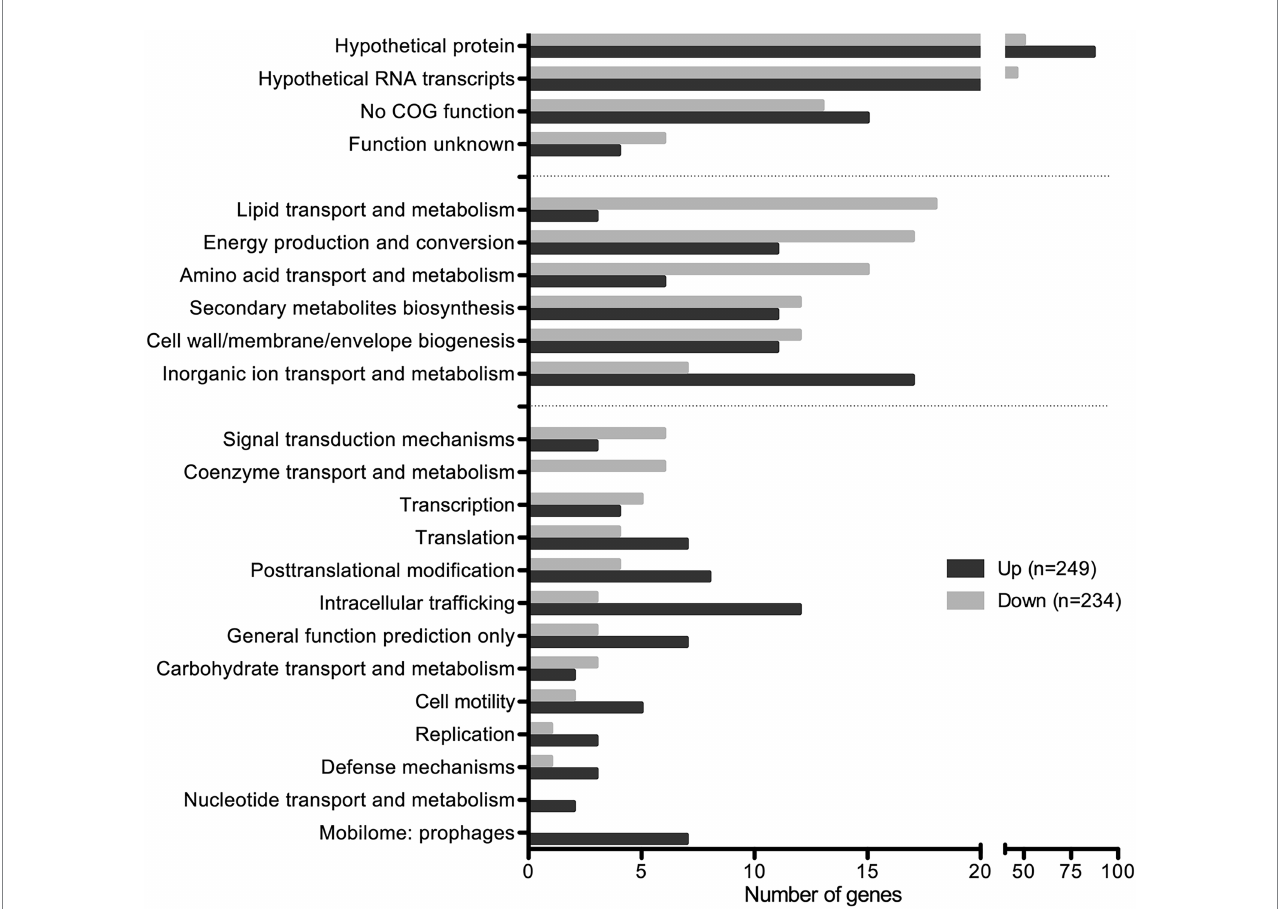
FIGURE 6 SapR disproportionally regulates hypothetical proteins. Differentially expressed genes (483) with statistical analysis ( q -value < 0.01) combined with a cut off of log 2 FC ≤ − 1 or ≥ 1 were analyzed by the Clusters of Orthologous Genes ( COG ) functional predictions. Hypothetical proteins, proteins of unknown function, proteins with no COG prediction, or hypothetical RNA transcripts account for approximately 50% of DEGs. Among the rest, the top functional categories (29%) regulated by SapR are lipid transport and metabolism, energy production and conversion, amino acid transport and metabolism, cell wall/ membrane/envelope biogenesis, secondary metabolites biosynthesis, transport and catabolism, and inorganic ion transport and